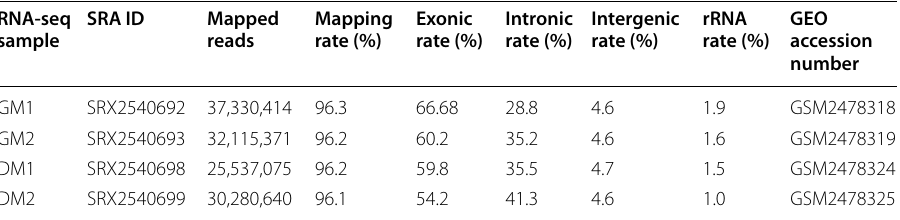
Table 1 RNA-seq quality metrics RNA‑seq SRA sample